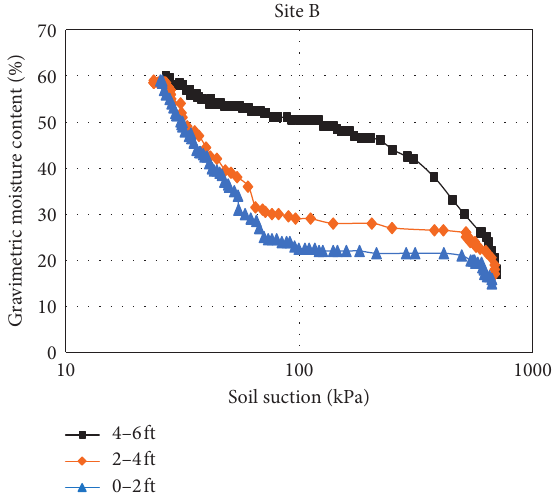
Figure 14: Soil-water characteristic curves (SWCC) for site B.